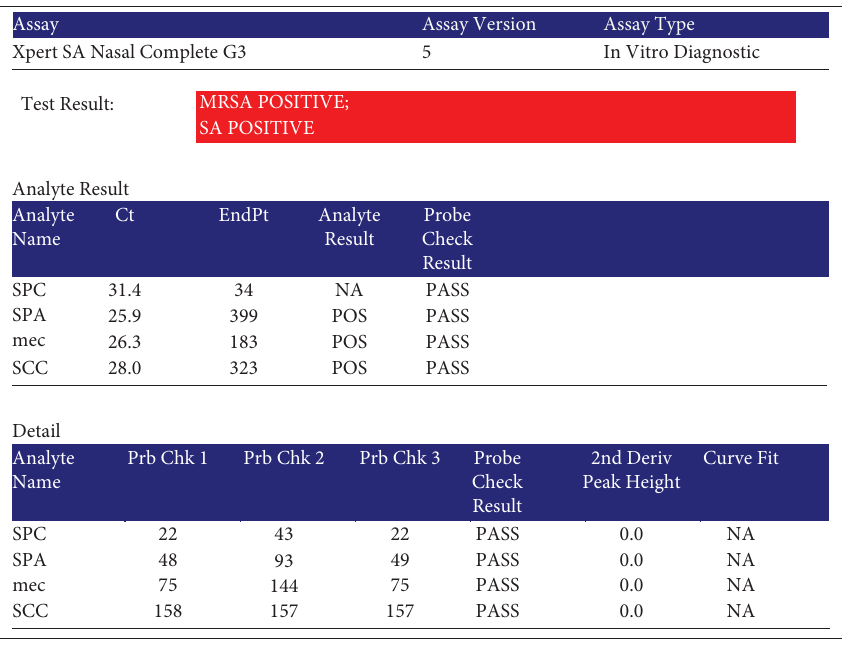
Figure 2: Xpert SA nasal complete G3 of the (mecA) and (SCCmec) MRSA positive